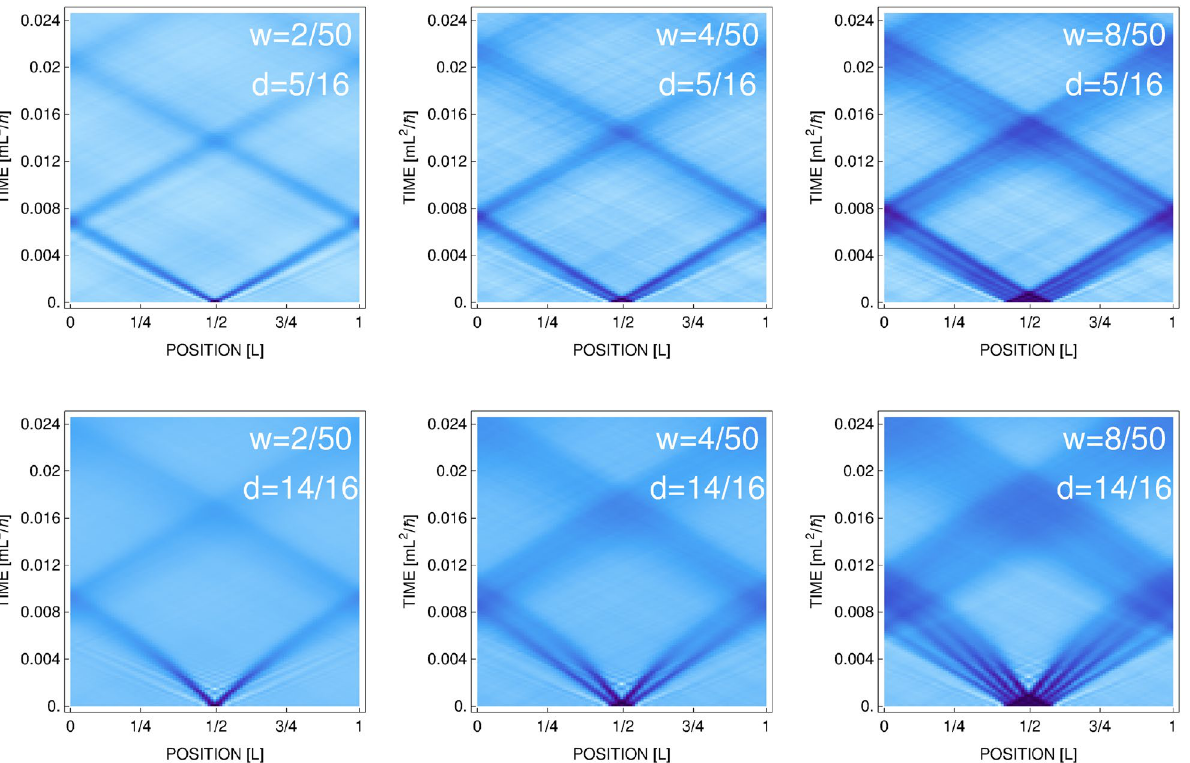
Figure 2. Time evolution of initially perturbed equilibrium state. Two-dimensional density of the system is first integrated along one direction, next averaged over approximately 100 realizations, and then shown as a function of time. Perturbation parameters, the width w and depth d are given in the frames. Temperature is T 0.025 mL 2 / (cid:31) corresponds to 50ms for L Total evolution time t = the healing